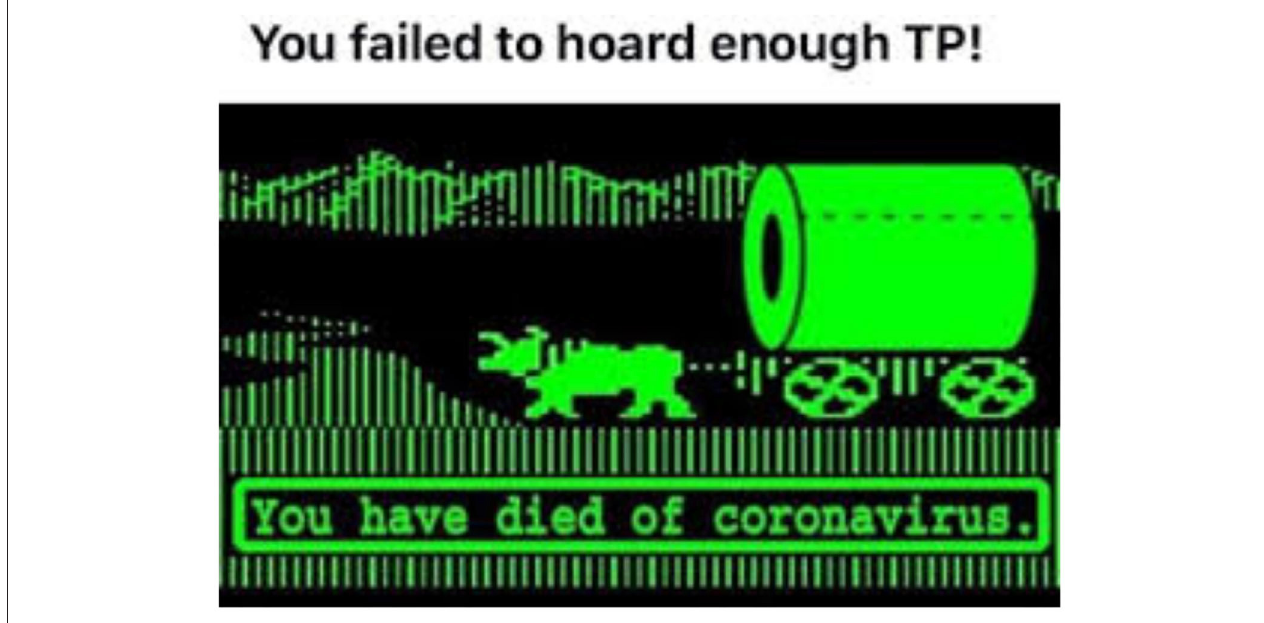
FIGURE 3 | Oregon Trail Toilet Paper Meme